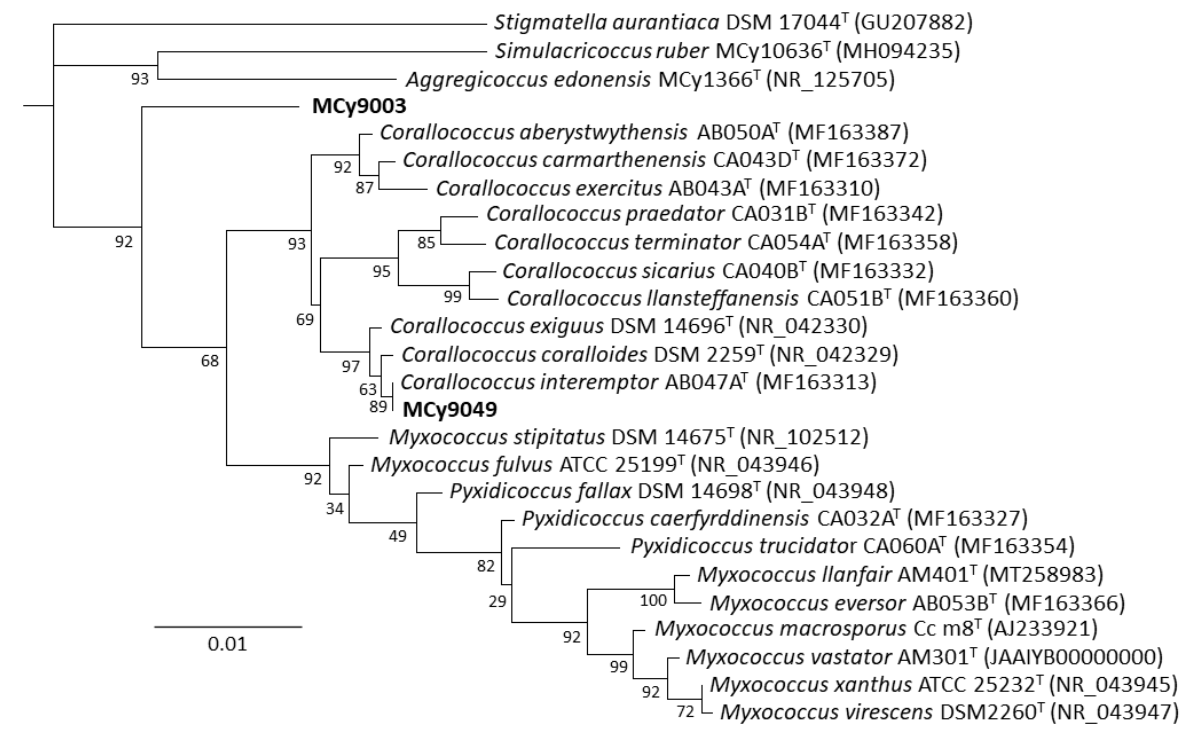
Figure 2. Phylogenetic tree (constructed using RAxML) inferred from 16S rRNA gene sequence showing the position of strains MCy9003 and MCy9049 in the Myxococcaceae clade. The sequence of Stigmatella aurantiaca DSM 17044 T was used as an outgroup to root the tree. GenBank accession numbers are given in parentheses. Bar, 0.01 nucleotide substitution per site.